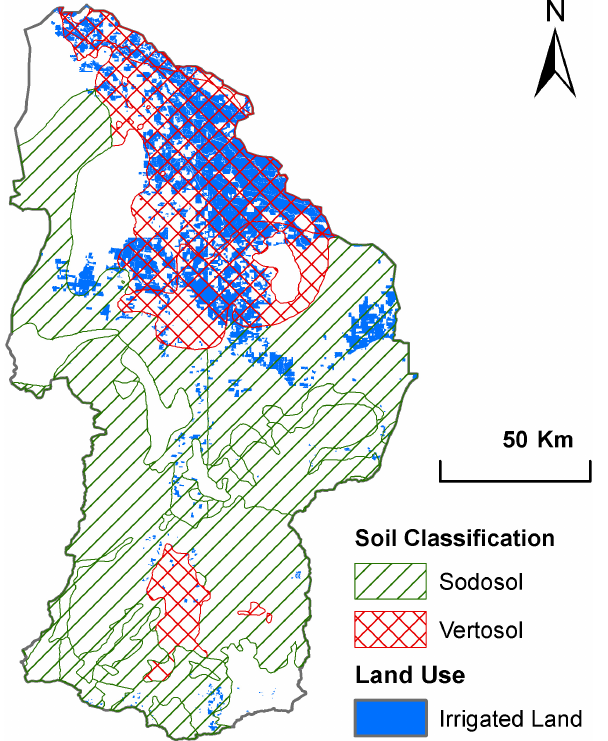
Fig. 9. Soil types and irrigation coverage within the Loddon catch- ment.